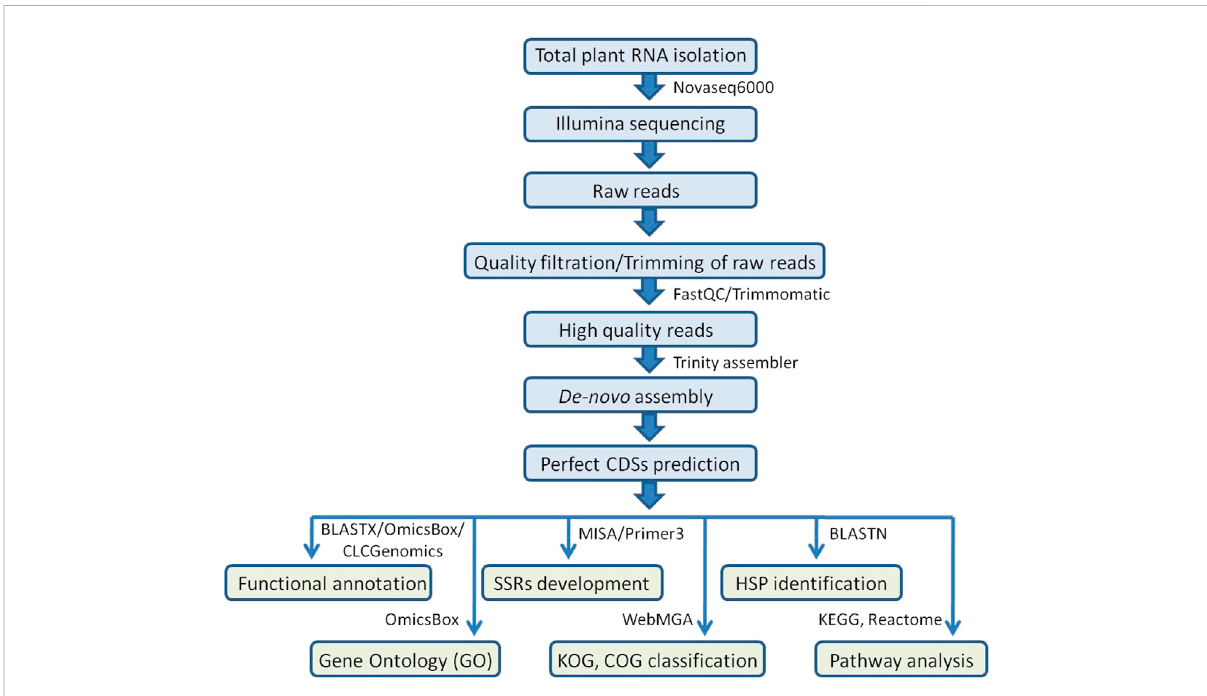
FIGURE 1 Work fl ow for Illumina sequencing, de-novo transcriptome assembly, functional annotations, SSR development, and identi fi cation of HSPs carried out in the allohexaploid